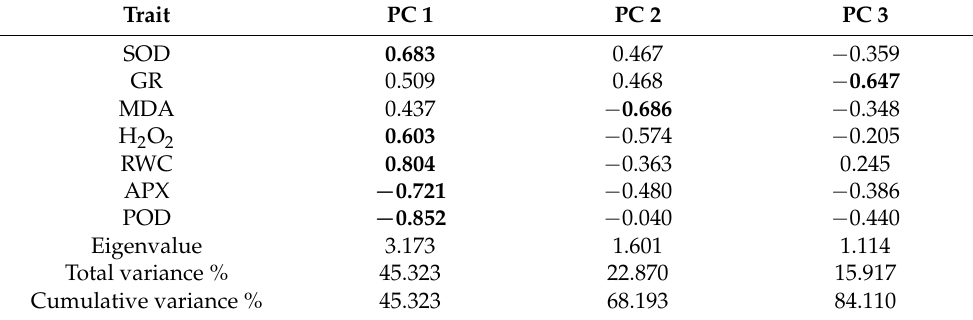
Table 4. Correlation between original variables and the first three principal components (PC), eigenvalues, and total variance in the evaluated pepper genotypes treated with two bacterial strains.